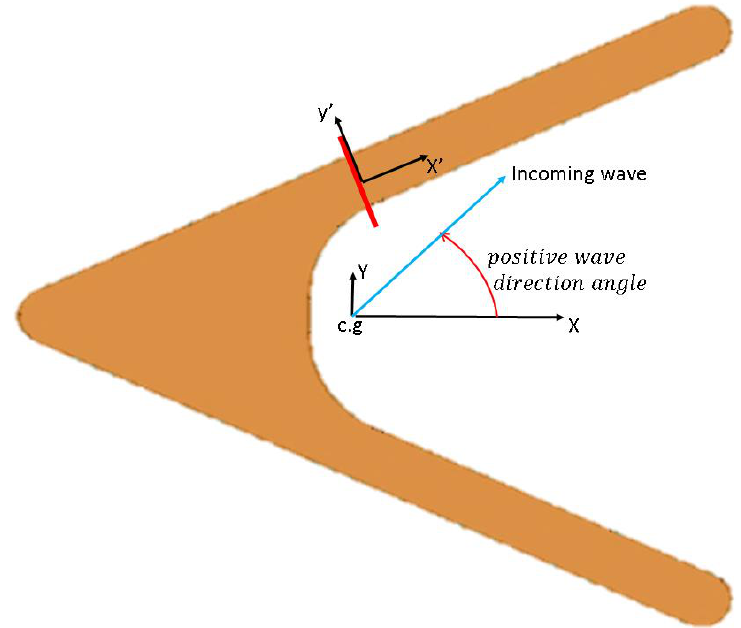
Figure 2. The Delta VLFS initial configuration (top view). The assumed critical cross section, marked with a red line, is at the connection of the side-hull to the front delta. The origin of the global coordinate system (𝒙,𝒚) is at the center of gravity of the structure, and the vertical axis is positive upwards from the calm free surface.